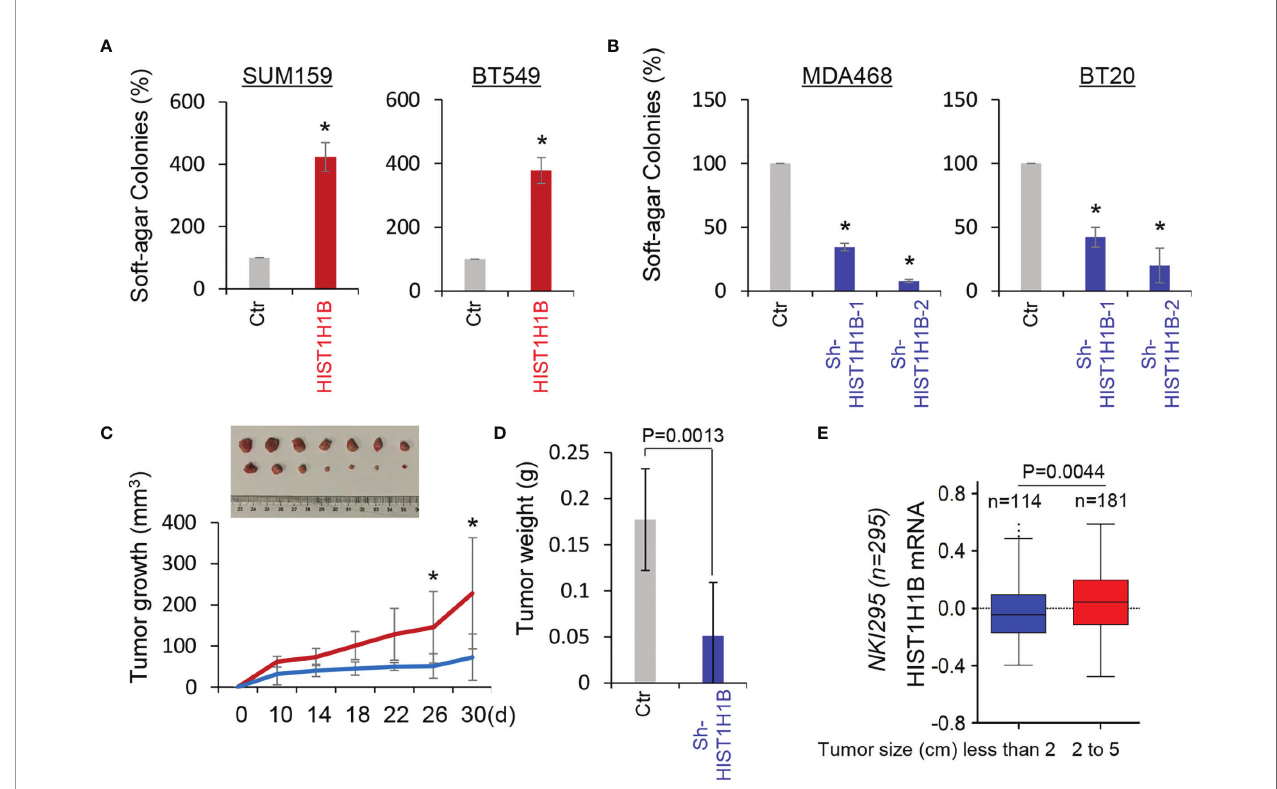
FIGURE 5 | Knockdown of HIST1H1B expression suppresses tumorigenicity in vitro and in vivo. (A, B) Soft-agar assay was performed using SUM159 and BT549 cells with stable empty vector or HIST1H1B expression (A) as well as MDA468 and BT20 cells with stable empty vector or knockdown of HIST1H1B expression (B) . Data are presented as the percentage of vector cell lines (mean ± SD in three separate experiments). *p < 0.01 by Student's t-test. (C, D) MDA468 cells with stable empty vector or knockdown of HIST1H1B expression were injected into the mammary fat pad of SCID mice. Tumor growth (C) was recorded every two days, and tumor weights (D) were measured. Data are presented as mean ± SEM from seven mice. *p < 0.05. (E) Box-plots indicated HIST1H1B expression in different tumor sizes of breast cancer from the NKI295 dataset. Comparisons are made using the two-tailed Student's